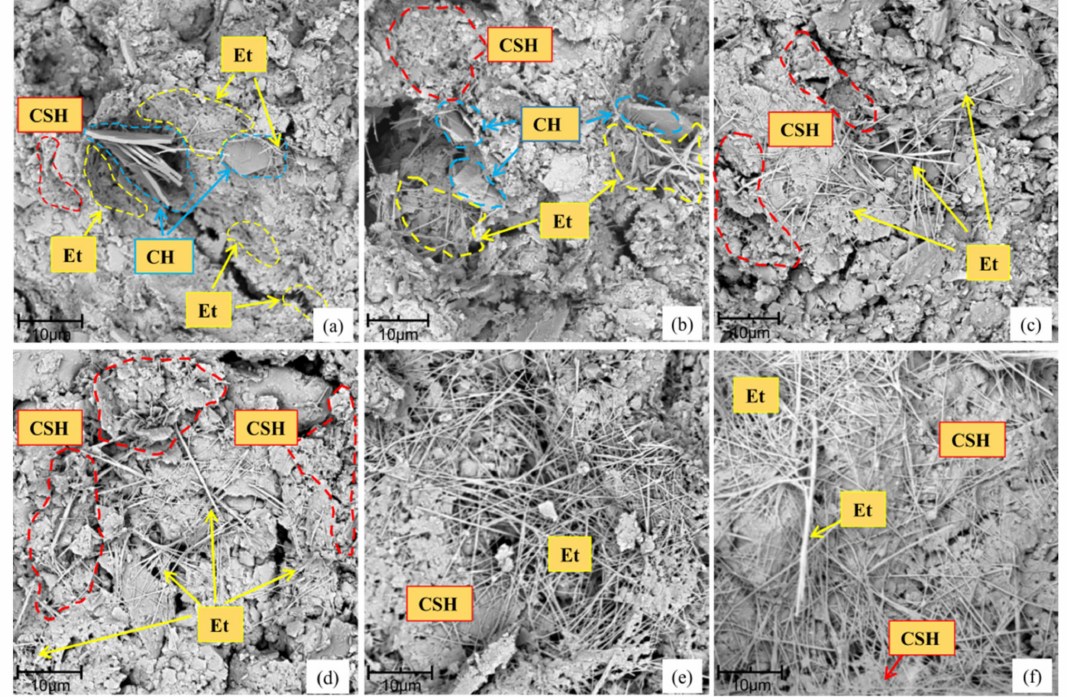
Figure 5. Microscopic images for samples with different curing times: ( a ) C10SF0 at 3 days; ( b ) C10SF1.5 at 3 days; ( c ) C10SF1.5 at 7 days; ( d ) C10SF1.5 at 14 days; ( e ) C10SF1.5 at 28 days; ( f ) C10SF1.5 at 90